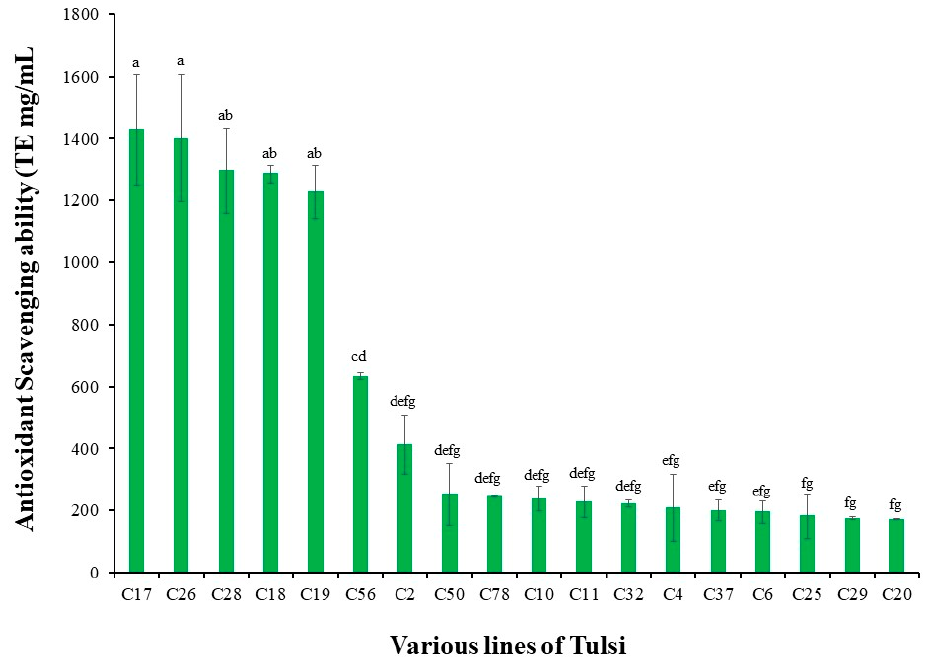
Figure 1. Average antioxidant scavenging activity of 18 lines of Tulsi compared to a Trolox equivalent ( µ mol TE/g) standard using 2,2-diphenyl-1-picrylhydrazyl (DPPH) antioxidant assay. Names on the x-axis represents an individual line from different seed lots. Vertical bar with same letters indicates no significant difference between treatments at ( p > 0.05). Data are displayed as mean, with bars representing standard error.